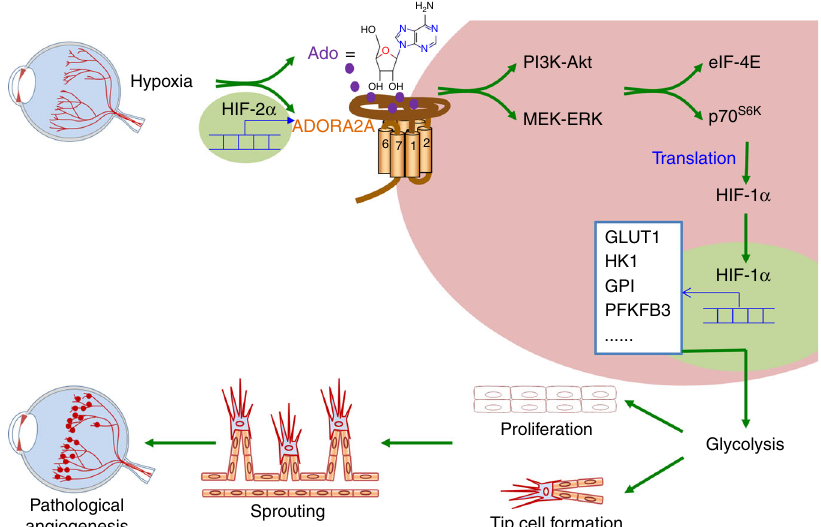
Fig. 10 Schematic diagram illustrating the molecular mechanisms underlying the angiogenic effect of adenosine-ADORA2A-mediated signaling